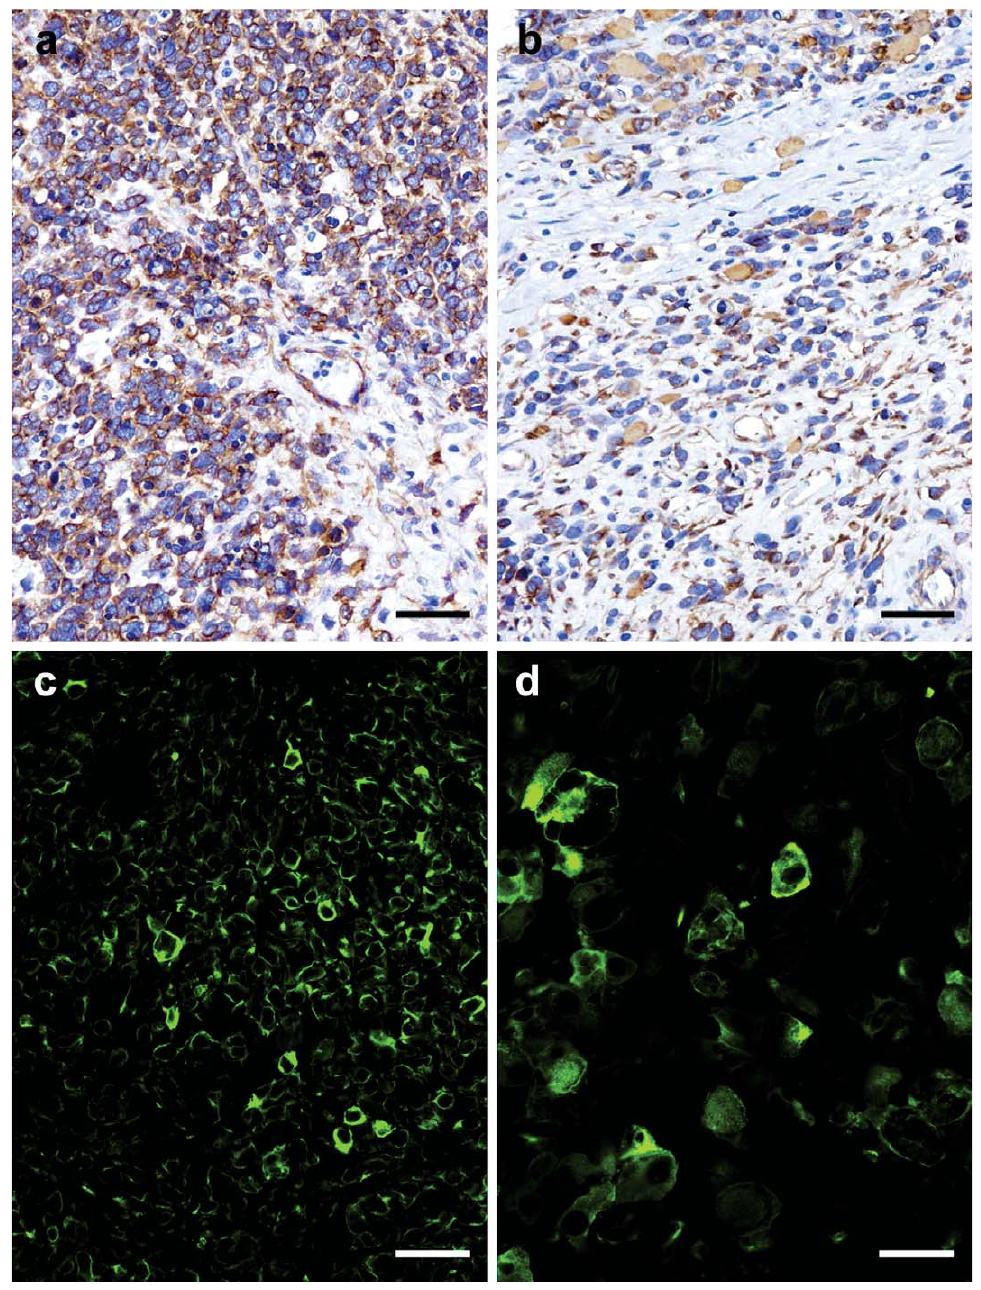
Fig.2. Immunohistochemicalandimmunofluorescenceanalysisofnestinexpressioninrhabdomyosarcomastissues.Strong,diffusecytoplasmic positivity in the majority of tumor cells with an internal positive control of Nes+ endothelial cells; sample 8 (a). Medium cytoplasmic nestin immunostaining in a subset of dispersed tumor cells; sample 7 (b). Nestin expression in a significant proportion of tumor cells; sample 8 (c). Nestin expression in individual tumor cells; sample 4 (d). Immunohistochemistry with Gill’s hematoxylin counterstain (a, b); indirect immunofluorescence using FITC-labeled secondary antibody (c, d). Bars, 100 (cid:1) m (a, b, c), 50 (cid:1) m